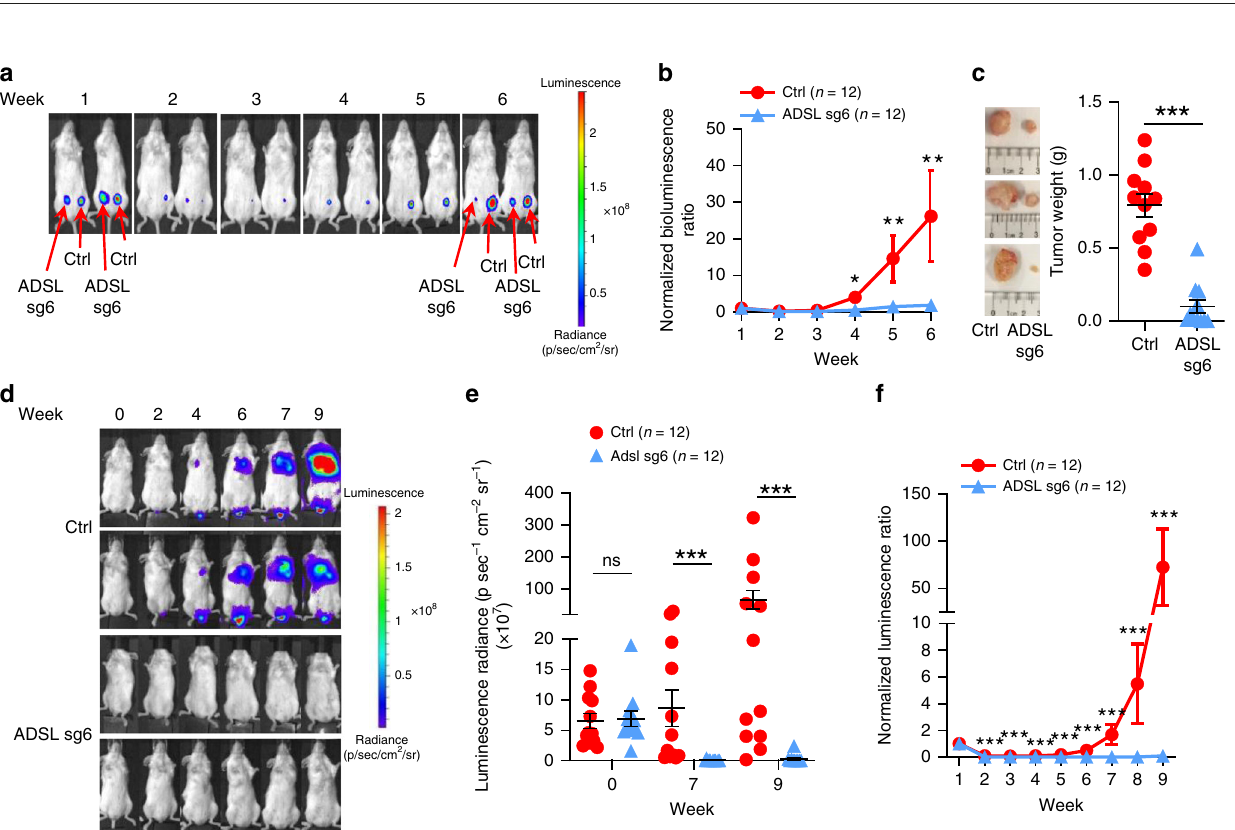
Fig. 2 ADSL plays an essential role in TNBC. a ADSL mRNA expression across different subtypes of breast cancer in three different datasets (TCGA stands for The Cancer Genome Atlas). The center line of the dox plots represents the median, the bounds the upper and lower quartiles, and the whiskers the 1.5× interquartile range. b ADSL mRNA expression in TNBC and normal breast tissue in TCGA, and IB of lysates from paired TNBC patient-derived non-tumor (n) and tumor (t) breast tissues. c Representative 2-D proliferation of indicated cells upon ADSL depletion shown by IB. d , e Representative images of ( d ) anchorage-independent growth and ( e ) invasion of MDA-MB-231 cells infected with either ADSL sgRNAs #5 and #6 (sg5 and sg6) or sgRNA control (Ctrl). Graphs represent the mean ± SEM from two independent experiments, each performed in duplicate ( d ), and from three independent experiments ( e ). ** P < 0.01 were calculated using one-way ANOVA followed by Dunnett ’ s multiple comparison test. f IB of lysates from MDA-MB-231 cells overexpressing doxycycline (dox)-inducible ADSL, infected with indicated virus and treated as indicated. g , h Representative images of ( g ) anchorage- independent growth and ( h ) invasion of MDA-MB-231 cells overexpressing dox-inducible ADSL, infected and treated as indicated. Graphs represent the mean ± SEM from four independent samples. * P < 0.05, ** P < 0.01, *** P < 0.001 were calculated using one-way ANOVA followed by Tukey ’ s multiple comparison test. Source data are provided as a Source Data fi le